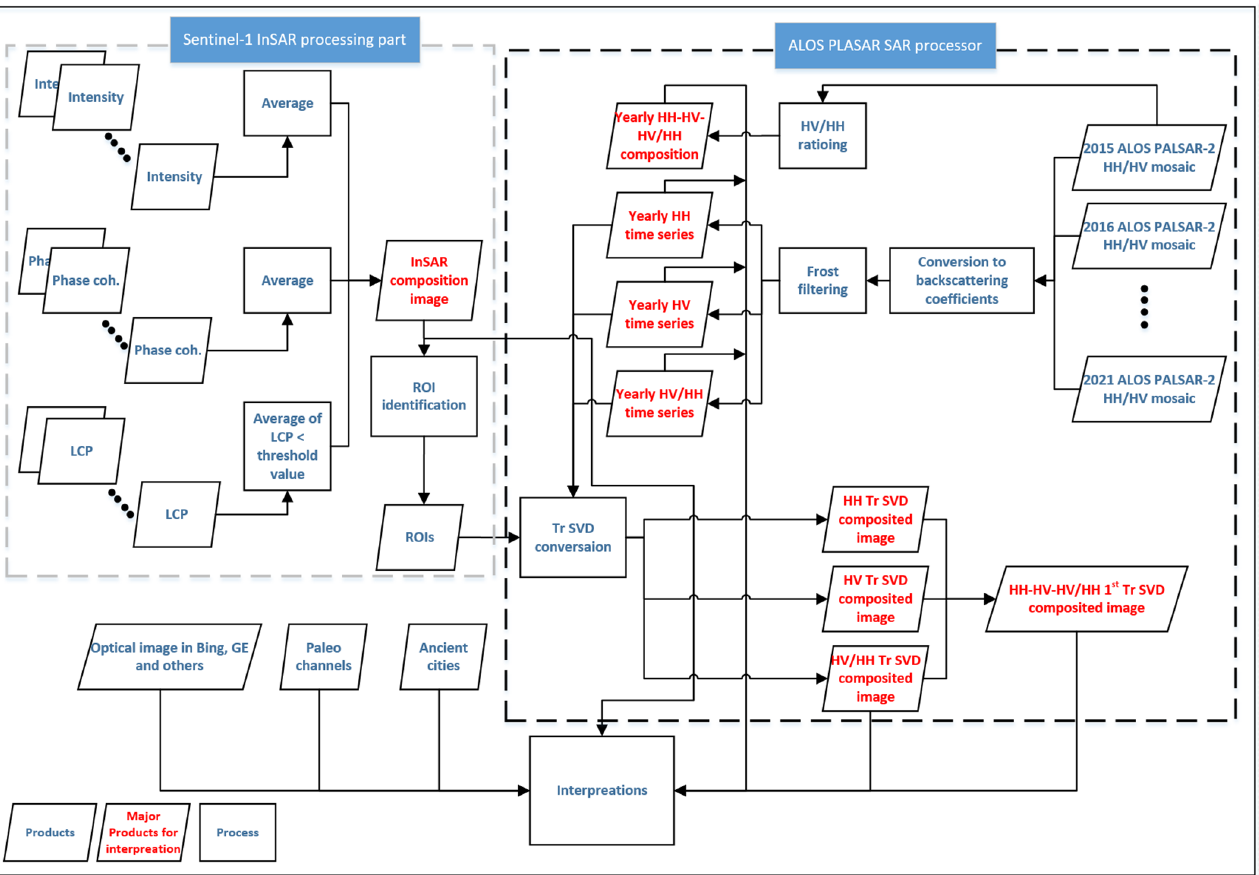
Figure 3. Overall processing fl ows and resulting products (hereafter InSAR as InSAR Comp., Yearly HH time series as HH TS Comp., HH-HV/HV/HH composition as 3 Ch pol. Comp., tr-SVD HH time series as HH TS Tr-SVD, HH-HV-HV/HH 1st Tr SVD as 3 Ch/1st Tr-SVD Comp.).